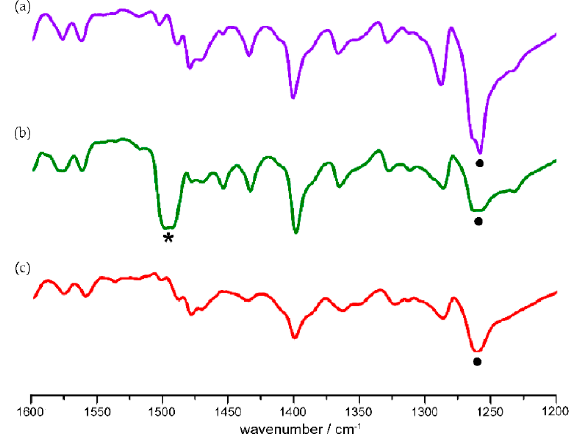
Figure 2. FTIR spectra of p -bromonitrosobenzene in KBr pellet ( a ) before photolysis at 12 K, ( b ) after 30 min of photolysis by a low-pressure Hg lamp, and ( c ) after warming to 170 K. The signal of E -ON=NO asymmetric stretching vibration is labelled with •, while the signal of monomeric N=O stretching vibration is labelled with * .